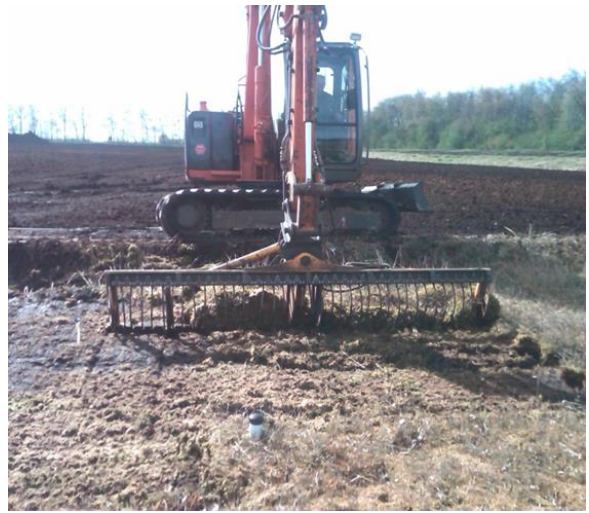
Figure 2. Excavator with mowing basket harvesting Sphagnum on the Ramsloh Test